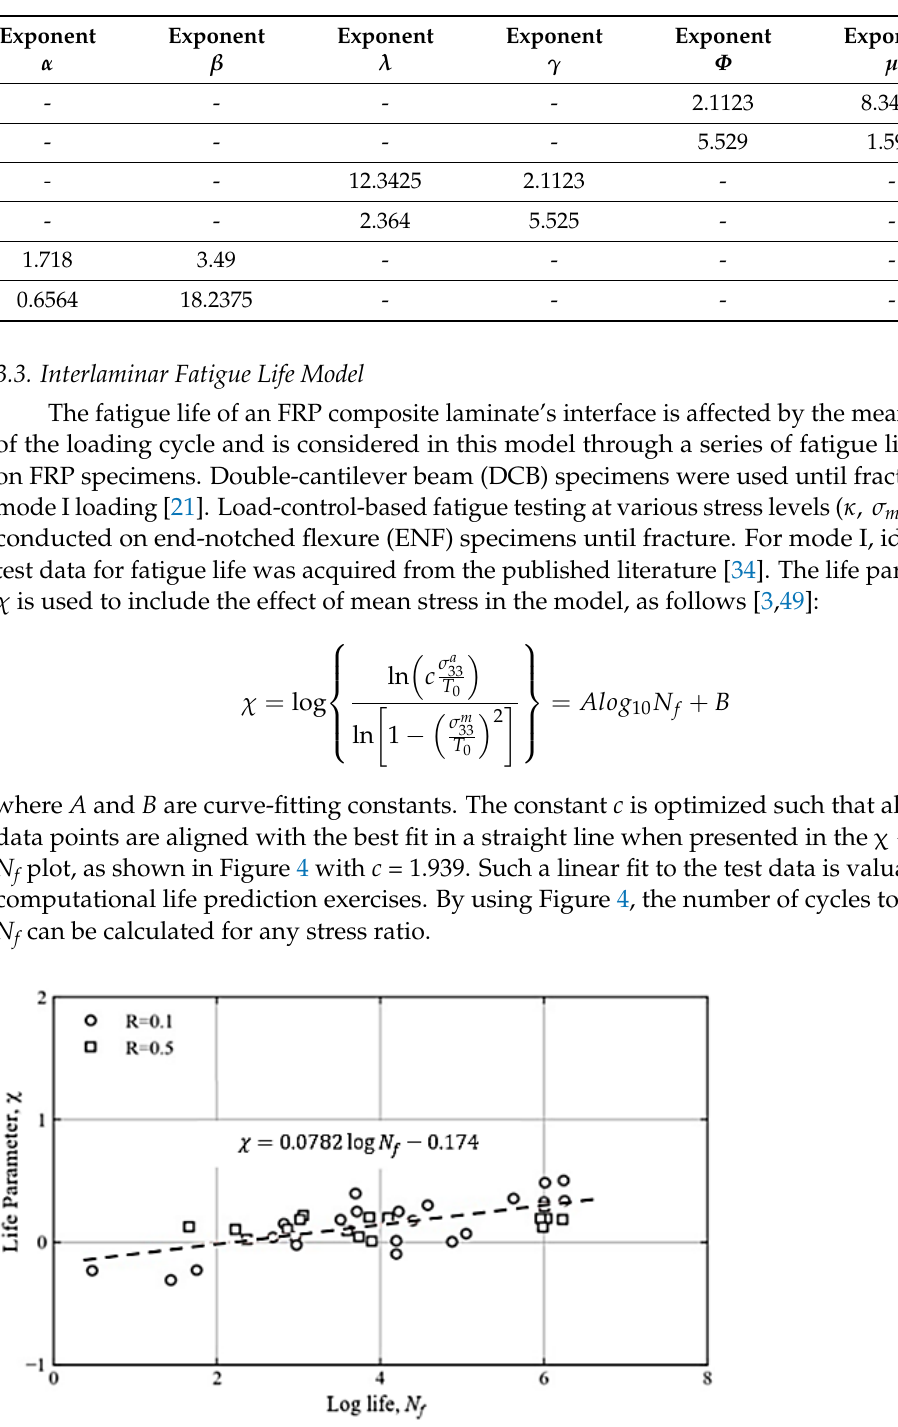
Table 2. Normalized model parameters.